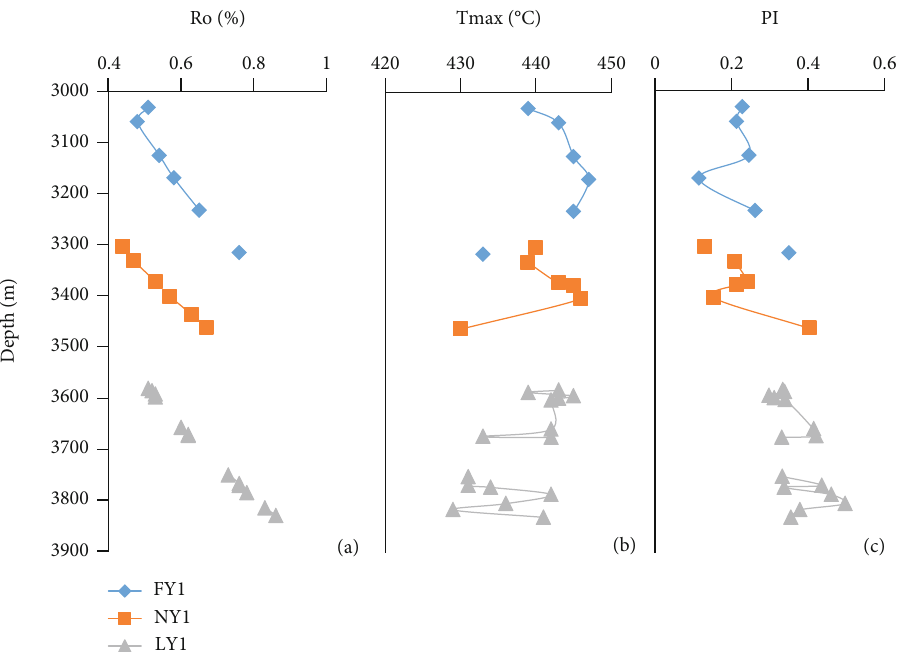
Figure 2: Depth pro fi le of maturity indicators at wells FY1, NY1, and LY1 in the Dongying Depression. (a) Measured vitrinite re fl ectance. (b) Rock-Eval T max . (c) Production